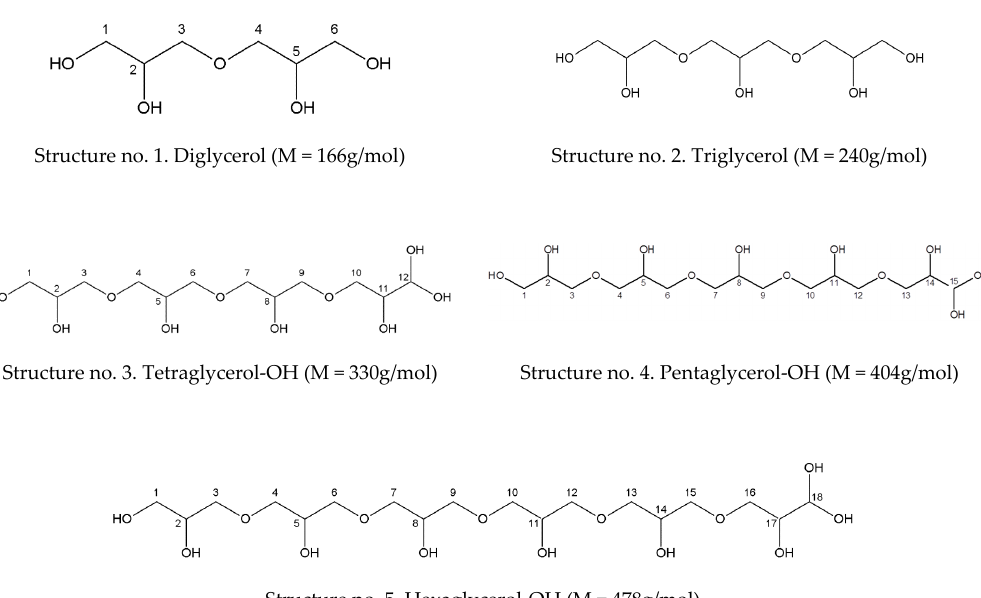
Structure no. 5. Hexaglycerol-OH (M = 478g/mol)